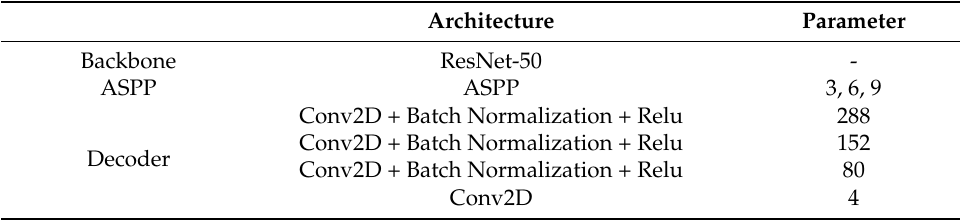
Table 1. Base model of the DeepLabV3-Refiner model.